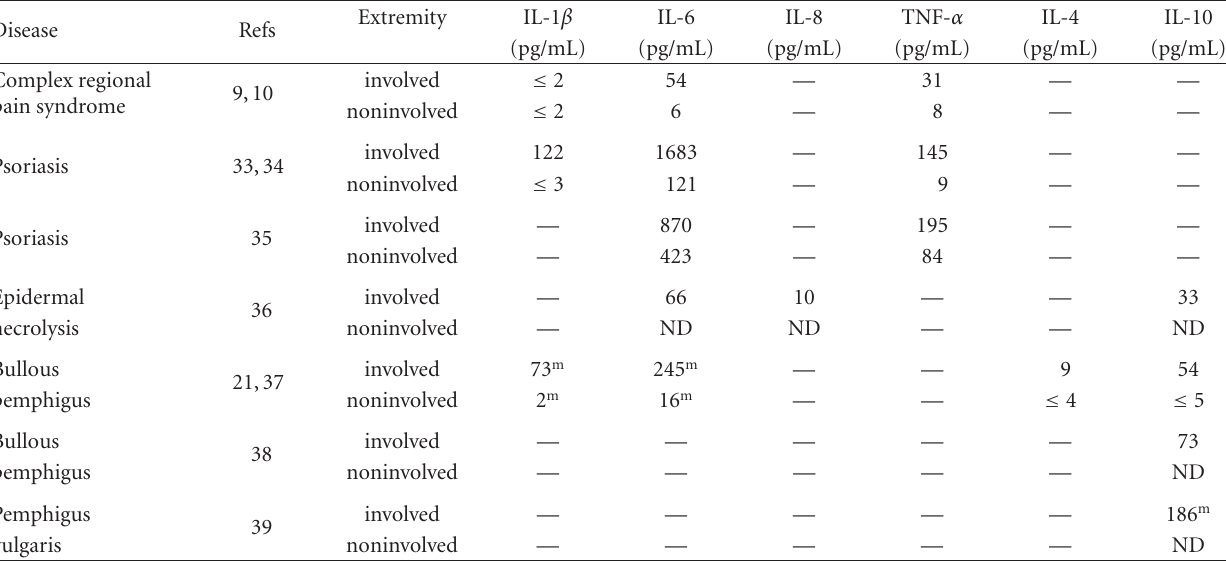
Table 1: Literature overview of cytokine levels in blister fluid measured by ELISA. Data are medians or otherwise means (indicated by m ). ND: not determined.